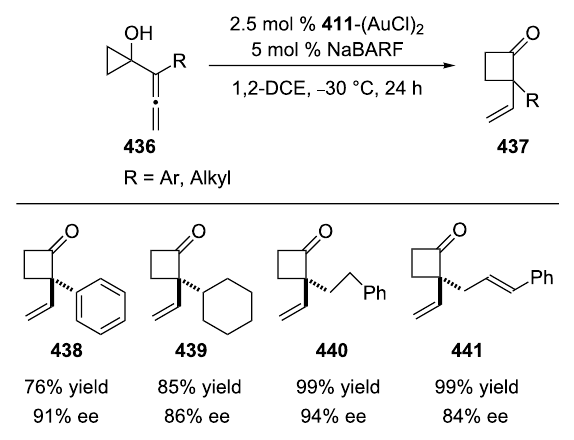
Scheme 71: Gold(I)-catalyzed enantioselective ring expansion of